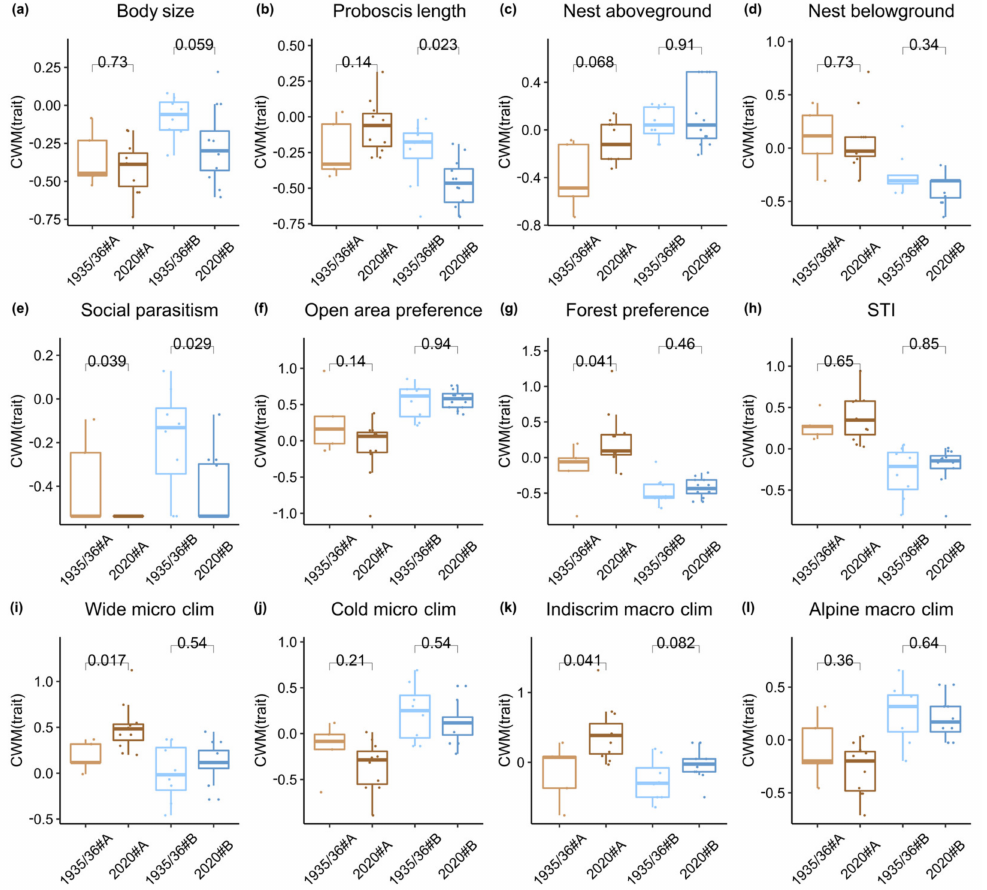
Figure 6. ( a – l ) Distribution of bumblebee species traits. For each cluster group, the CWM (com- munity weighted mean) values of the ( a ) worker body size in millimeters, ( b ) worker proboscis length in millimeters, ( c ) share of aboveground nesting species, ( d ) share of belowground nesting species, ( e ) share of social parasitic species, ( f ) habitat preference for open areas, ( g ) habitat preference for forests, ( h ) a species temperature index (STI) according to Rasmont et al. [20], ( i ) wide microcli- matic preference, ( j ) cold microclimatic preference, ( k ) indiscriminate macroclimatic preference, and ( l ) alpine macroclimatic preference are shown. Traits have been scaled and centered prior to CWM calculation, and y axes hence show transformed values. The first character string of cluster groups as shown on the x axis denotes the sampling year (1935/1936 or 2020), and the second denotes the group (mean elevation of 1550 masl (brown, A) and 2150 masl (blue, B)). Boxes represent CIs, lines represent means, and boxes represent +/ − 1.5* (interquartile range). Dots represent actual values of sampling units. Letters indicate p -values of the Kruskal-Wallis rank sum test comparing the two sampling periods of the two cluster